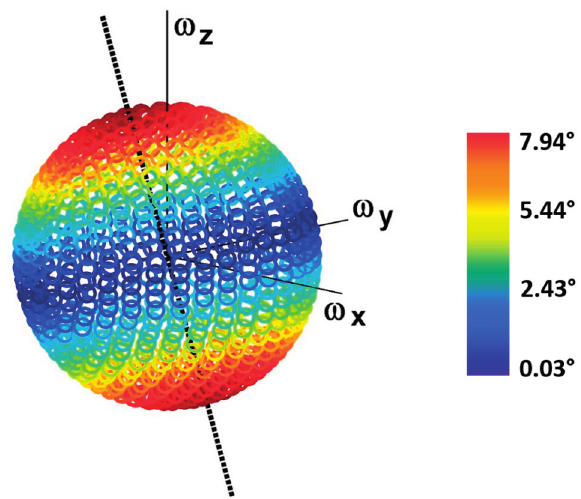
Figure 7. Distribution of the orientation error due to an RB aligned with the mean direction of the angular velocity in the shank across the sphere representing different 3D distributions of a constant unit angular velocity vector. The error is represented by a color range, from dark red (maximum values) to dark blue (minimum values). The dashed black line represents the direction of the RB